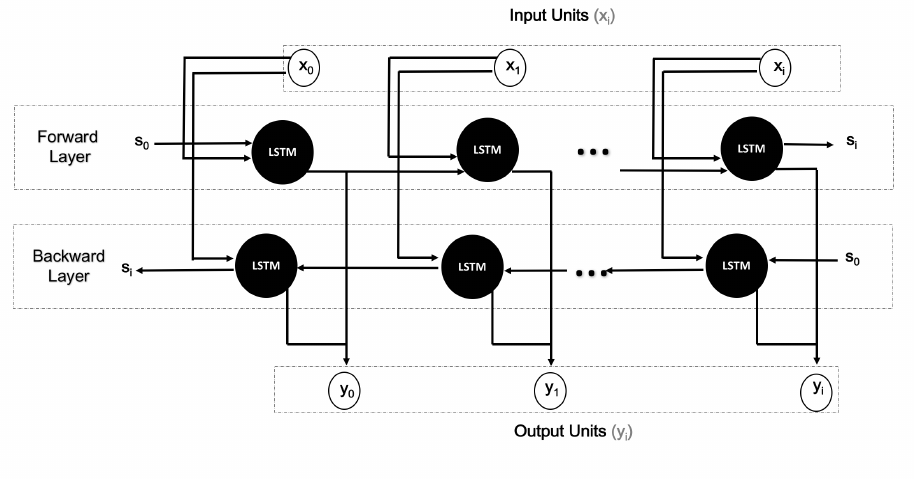
Figure 4. Architecture of a Bi-directional long short-term memory (BiLSTM)